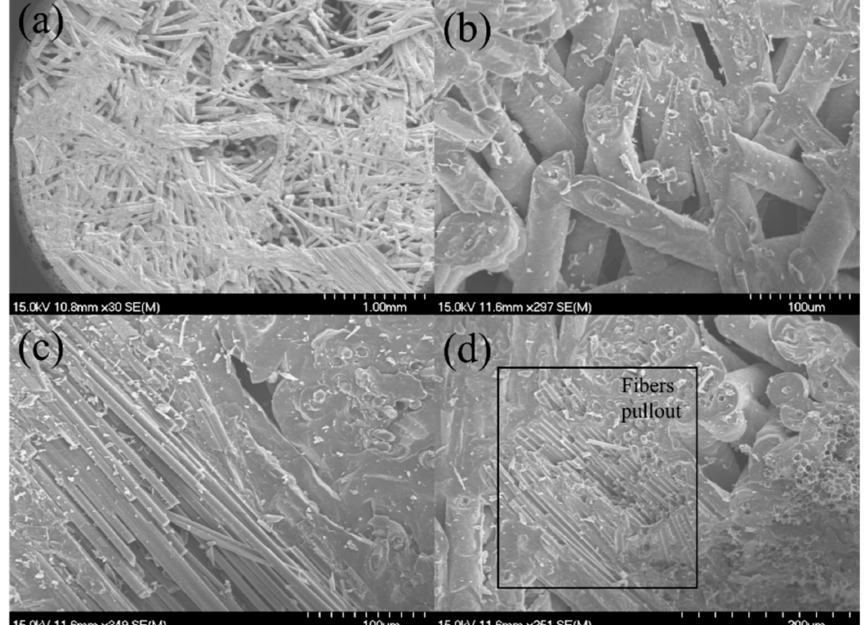
Figure 5. Interlaminar shear fracture surface of the 12k T-700 TM MWK–N–C/SiC specimen ob- served under SEM. ( a ) fracture surface of MWK–C/SiC specimen; ( b ) fracture fiber of MWK–C/SiC specimen; ( c ) needled fiber fracture in MWK–N–C/SiC specimen; ( d ) needled fiber pullout in MWK– N–C/SiC